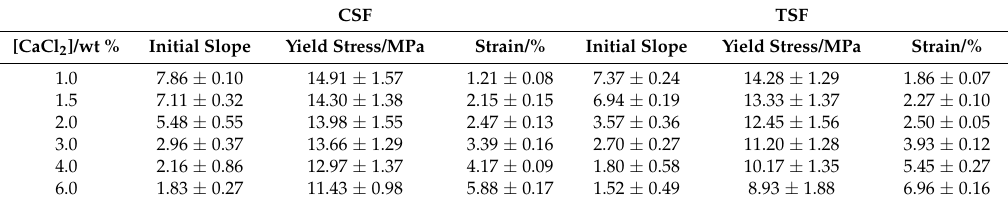
Figure 3. The stress-strain curves of CSF ( a ) and TSF ( b ) samples regenerated from 1.0% (solid square), 1.5% (hollow square), 2.0% (solid circle), 3.0% (hollow circle), 4.0% (solid triangle), and 6.0% (hollow triangle) CaCl 2 /FA solutions. Table 7. Mechanical properties of CSF and TSF samples measured by DMA *.